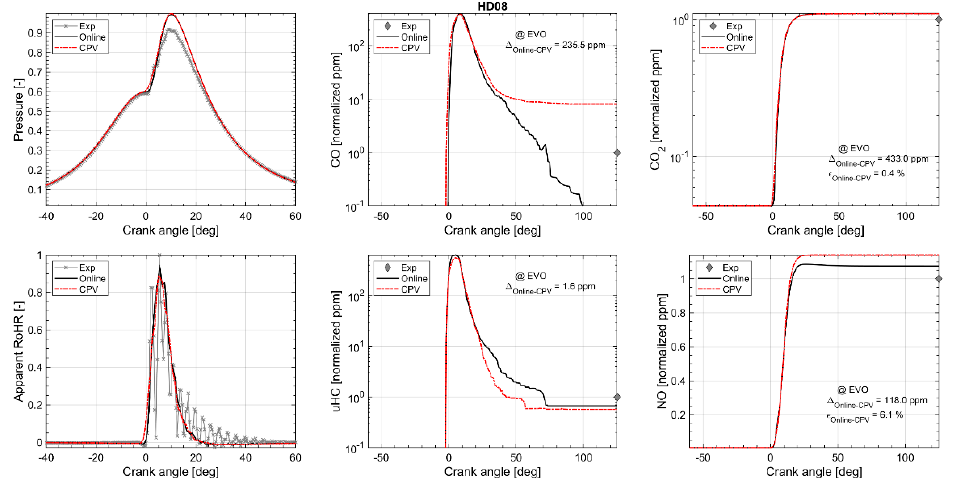
Figure A8. Engine performance and emissions for operating point HD08 (1000 rpm, 6.0 bar IMEP).